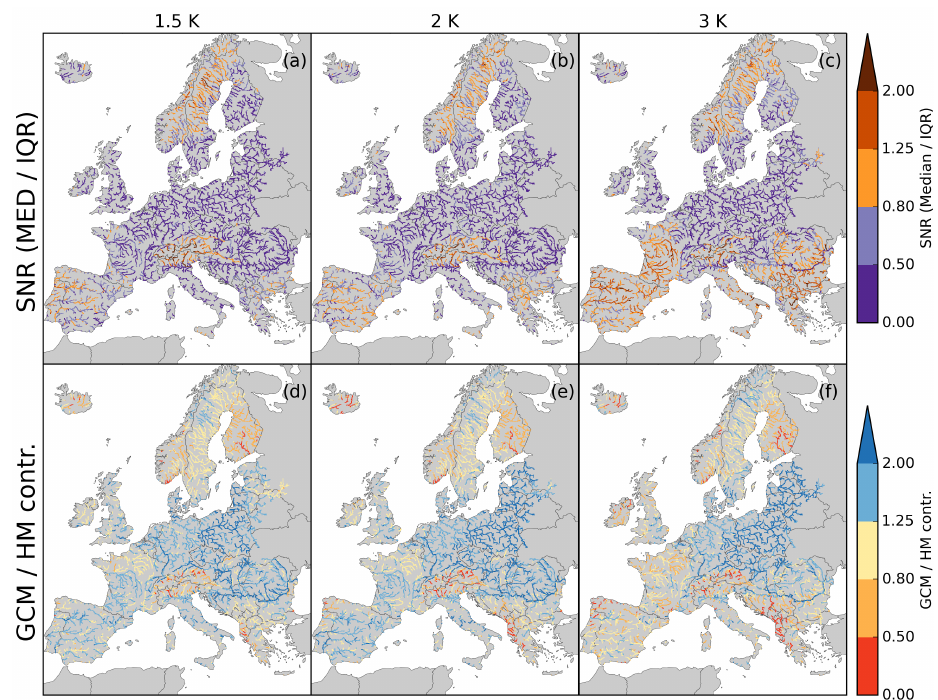
Figure 6. The upper row (a–c) shows the SNR (ensemble median divided by the inter-quartile range) for the change in low flows (Q90) between the 1980s and 1.5K (a) , 2K (b) , and 3K (c) warming. The relative uncertainty contribution of GCMs and HMs is shown in the lower row (d–f) for the three warming levels. Low values of GCM/HM indicate large HM uncertainty; values larger than 1 indicate a higher contribution of the GCMs to the total